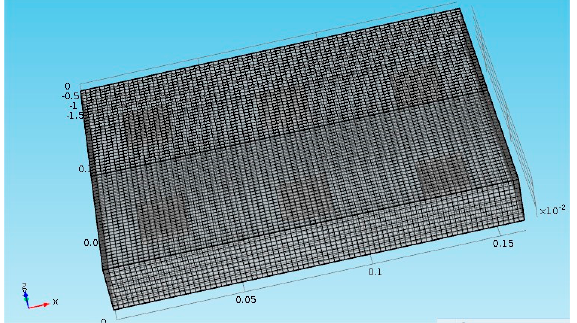
Figure 2. Meshing of the sample studied.